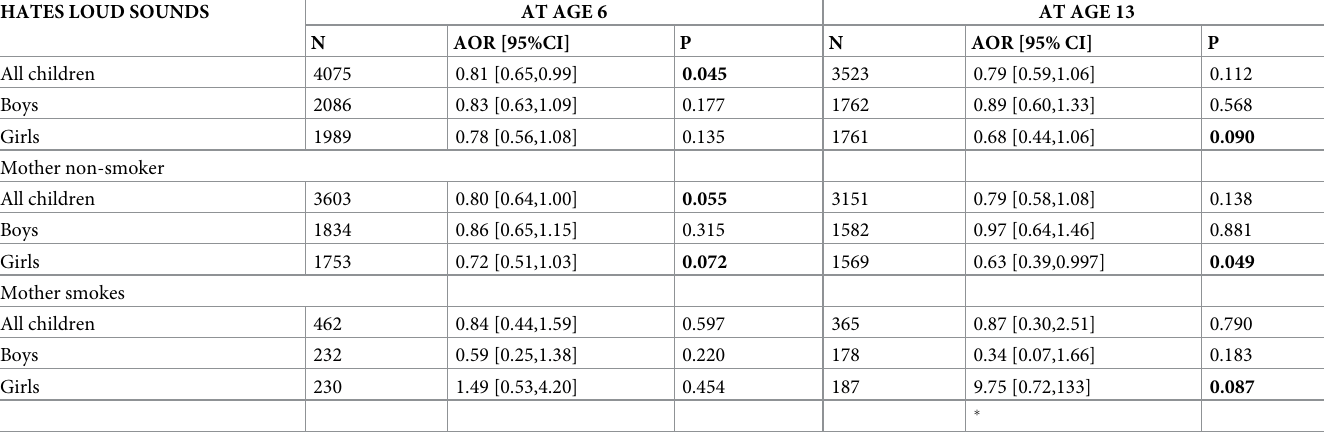
Table 5. Adjusted risk of the child hating loud sounds at ages 6 and 13 if the paternal grandmother had smoked in pregnancy. [P values < 0.10 are in bold]. Adjusted for year of birth of each paternal grandparent, age of grandfather at birth of the father, ethnic origins of both grandparents. HATES LOUD